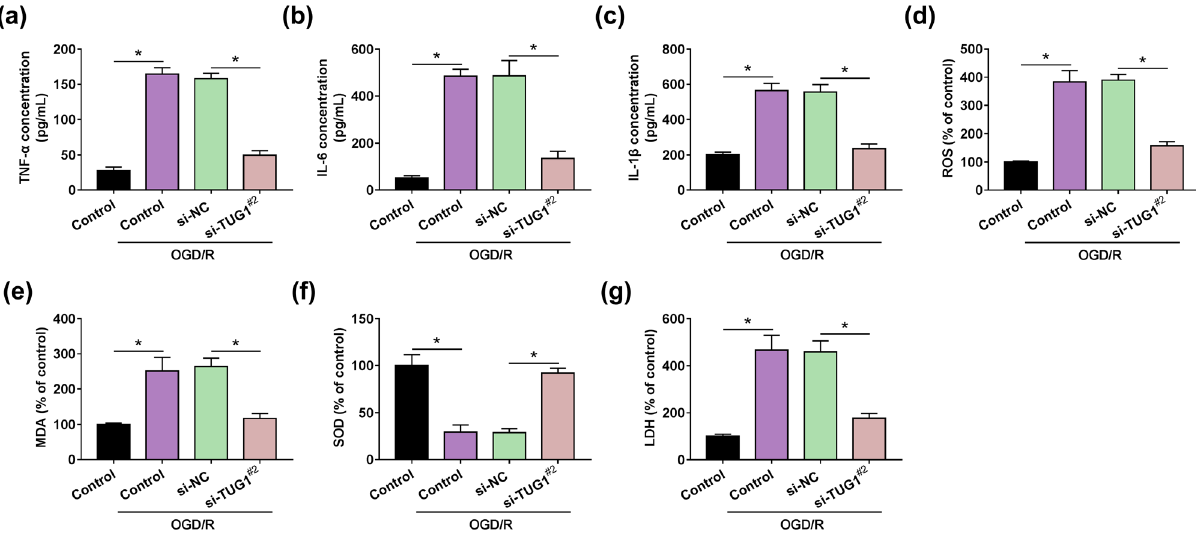
Figure 3: Knockdown of TUG1 attenuated the e ff ects of OGD/R on the in fl ammation and oxidative stress of N2a cell. ( a – c ) The concentration of TNF - α , IL - 6 and IL - 1 β was measured by ELISA in N2a cells with or without being treated by OGD/R. ( d ) Reactive oxygen species assay kit analyzed the ROS generation in N2a cells with or without being treated by OGD/R. ( e – g ) The intracellular levels of MDA, SOD and LDH were measured by colorimetry. * P < 0.05.